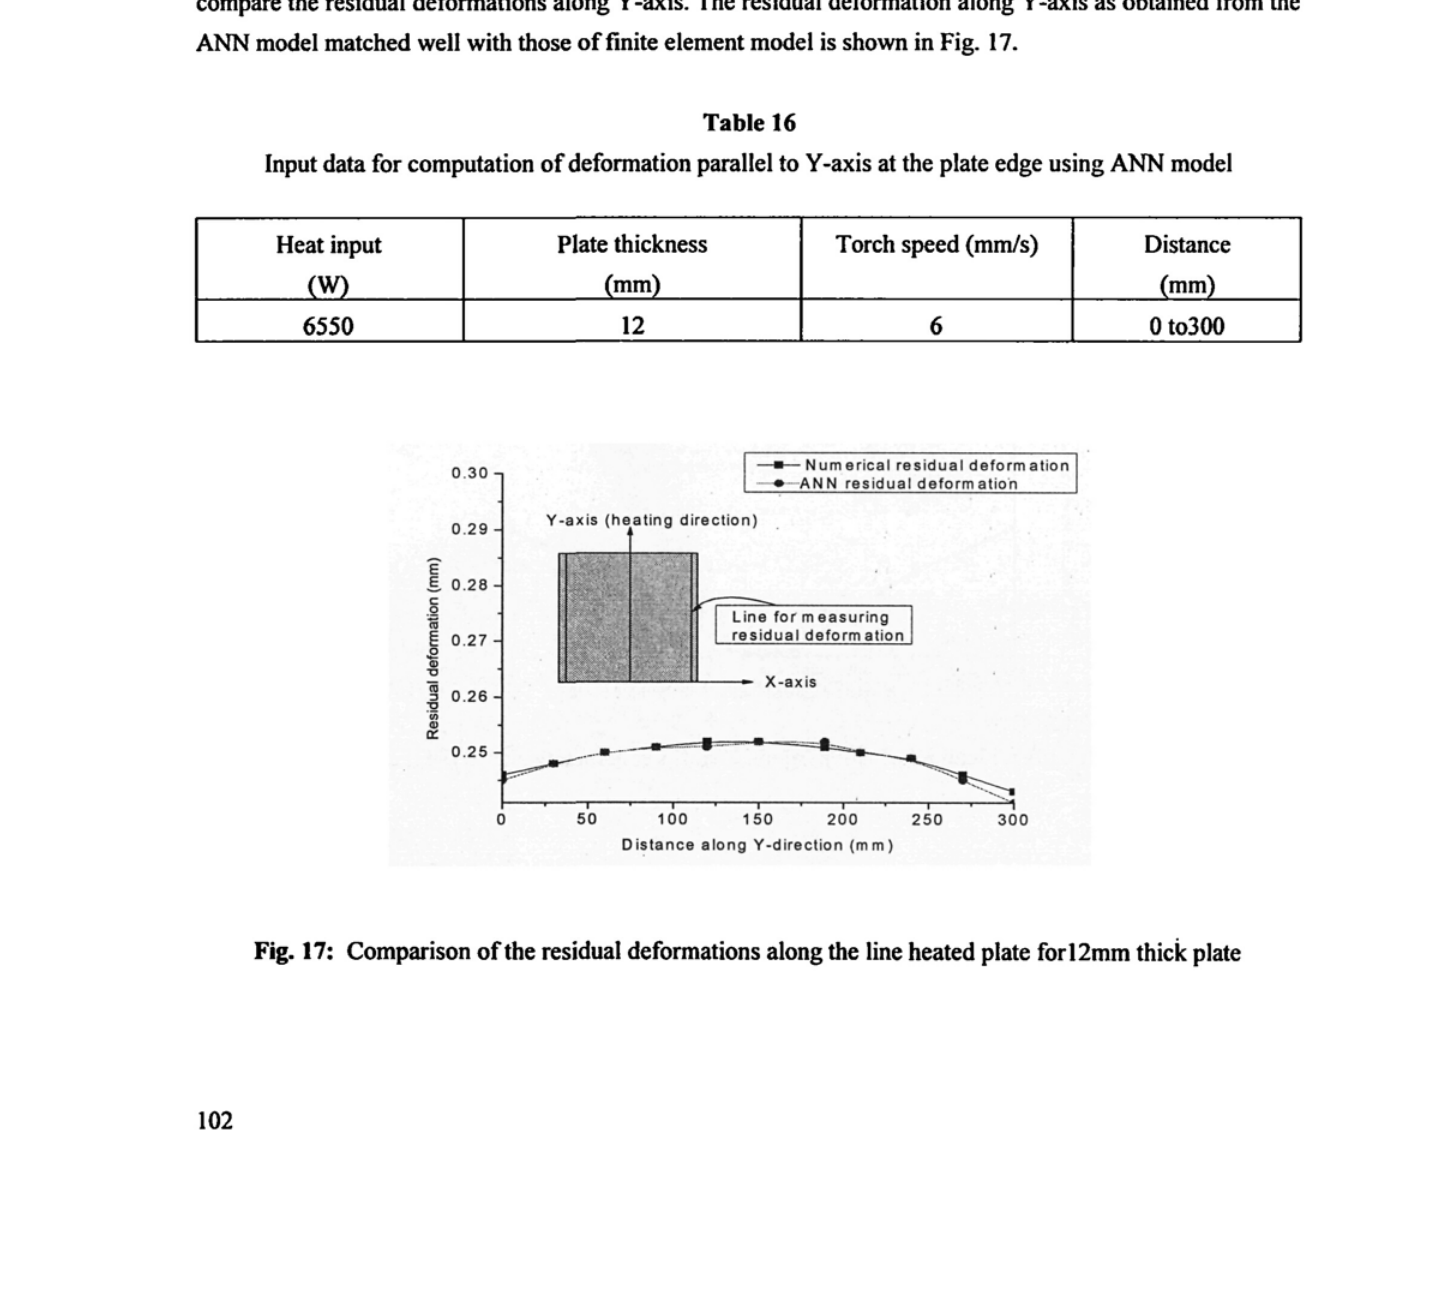
Numerical input / output data range trained in neural learning network for deformation along Y-axis